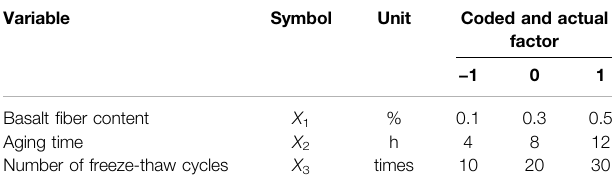
TABLE 6 | Factor and level coding of BBD. Variable